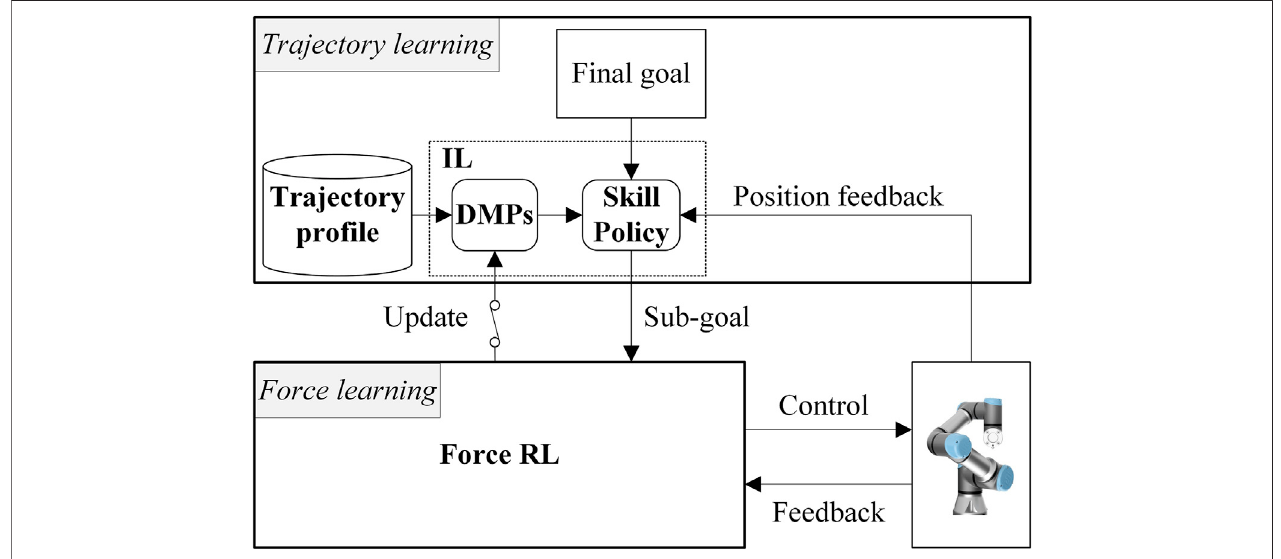
FIGURE 1 | System overview of the adaptive robotic imitation framework. The upper and the lower part are the trajectory learning and the force learning parts, respectively. The switch symbol between the reinforcement learning (RL) agent and the dynamical movement primitives (DMPs) module means the update of DMPs is executed using a modular learning